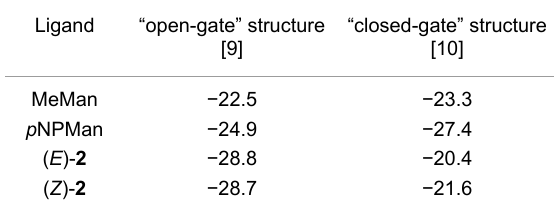
Table 3: FlexX scoring values for the ( E )- and the ( Z )-isomer of 2 based on two different crystal structures in comparison to MeMan and p